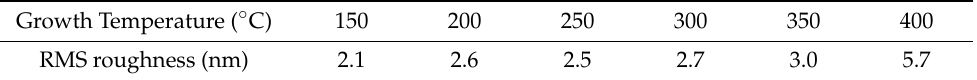
Table 1. CdSe thin film roughness estimation from atomic force microscopy analysis. Growth Temperature ( ◦ C)